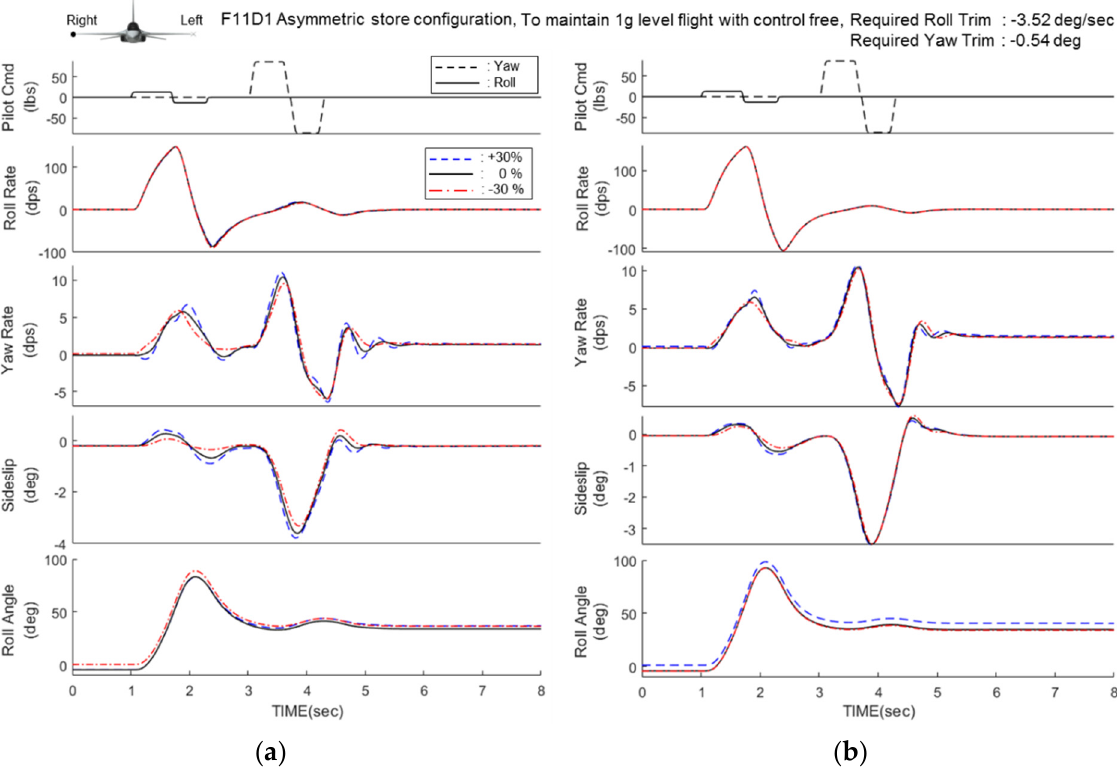
Figure 10. Robustness analysis results of the control system on N (cid:48) 20 Kft altitude ( a ) K aug = 0.0, ( b ) K aug = 0.8.